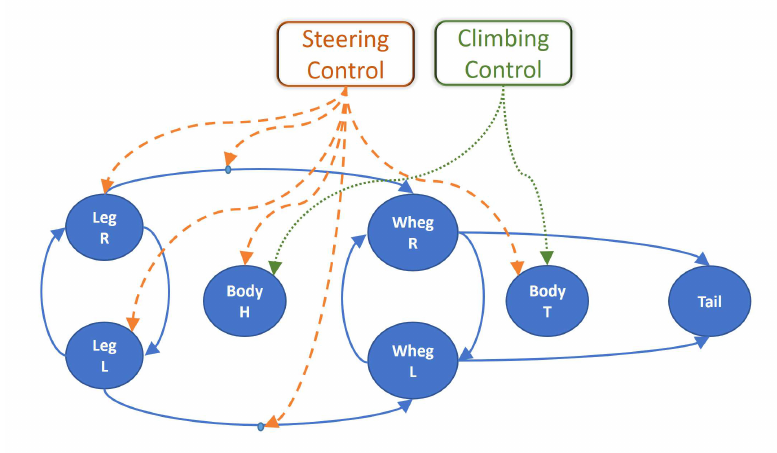
Figure 7. Topology of the locomotion control network. Steering and climbing control strategies act on motor neurons and connection parameters to affect the network